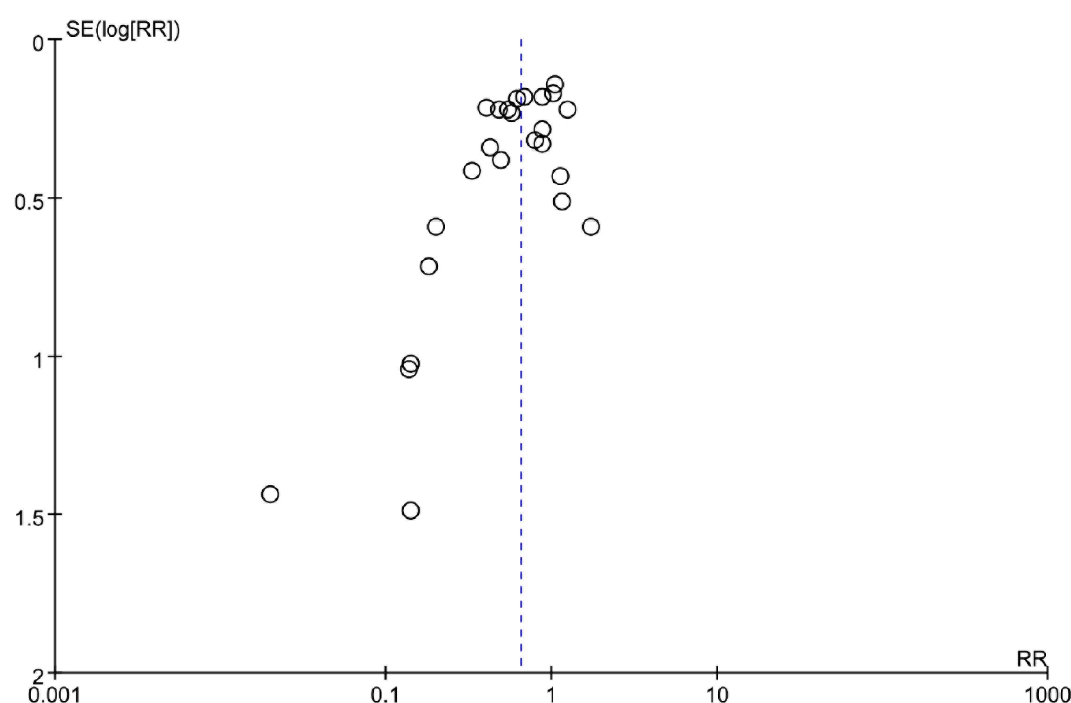
Figure 7. The funnel plot of the incidence of hypotension.